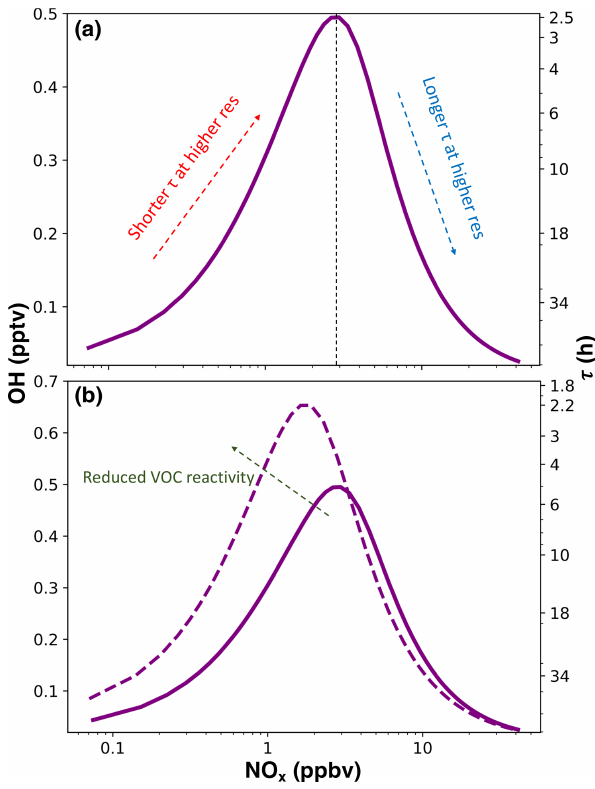
Figure A1. (a) Illustration of the daytime NO x –OH lifetime feed- back. Higher-resolution modeling tends to concentrate the most NO x emissions near sources, thus will decrease NO x lifetime in the NO x -limited regime (left) and increase NO x lifetime in the NO x - saturated regime (right). The steady-state concentrations were cal- culated assuming a NO 2 / NO ratio of 4, an alkyl nitrate branching ratio of 0.04, a VOC reactivity of 3s − 1 and an initial ozone con- centration of 25ppb, and the production of HO x is proportional to ozone. Panel (b) is the same as (a) but including an additional sce- nario where the VOC reactivity is reduced by 50%